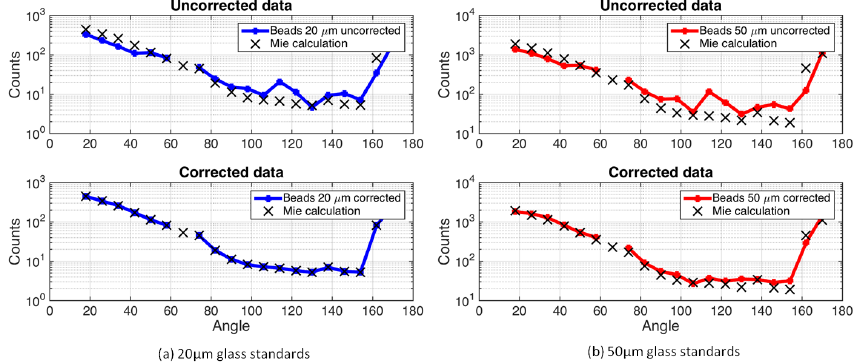
Figure 9. Theoretical (black crosses) and experimental (coloured solid lines) scattering phase functions of two standard glass bead ensembles of 20µm (blue) and 50µm (red) diameters. The upper panels show the raw background corrected intensities, and the lower panels show the crosstalk corrected intensities. The missing experimental point at 66 ◦ is due to a failure in the corresponding physical channel during the